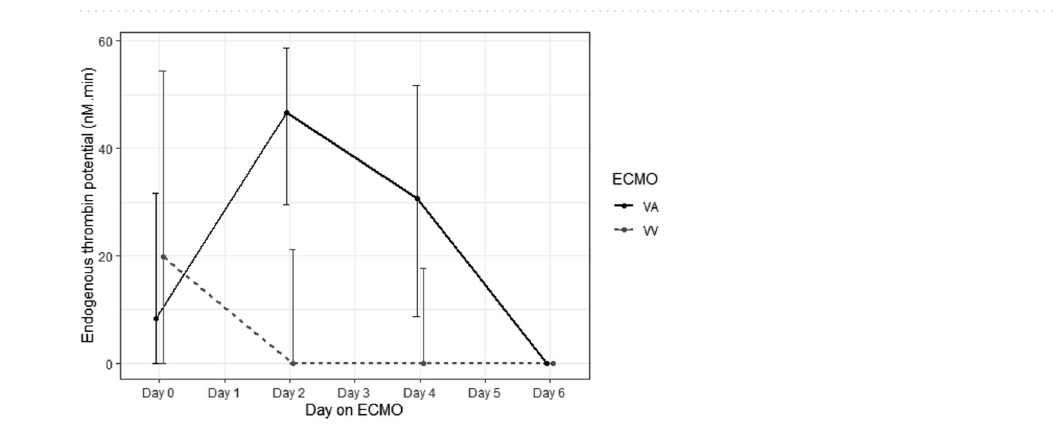
Figure 2. Total daily heparin dose on all ECMO patients demonstrating no significant relationship to ( A ) APTT and a significant relationship to ( B ) Anti-FXa levels.